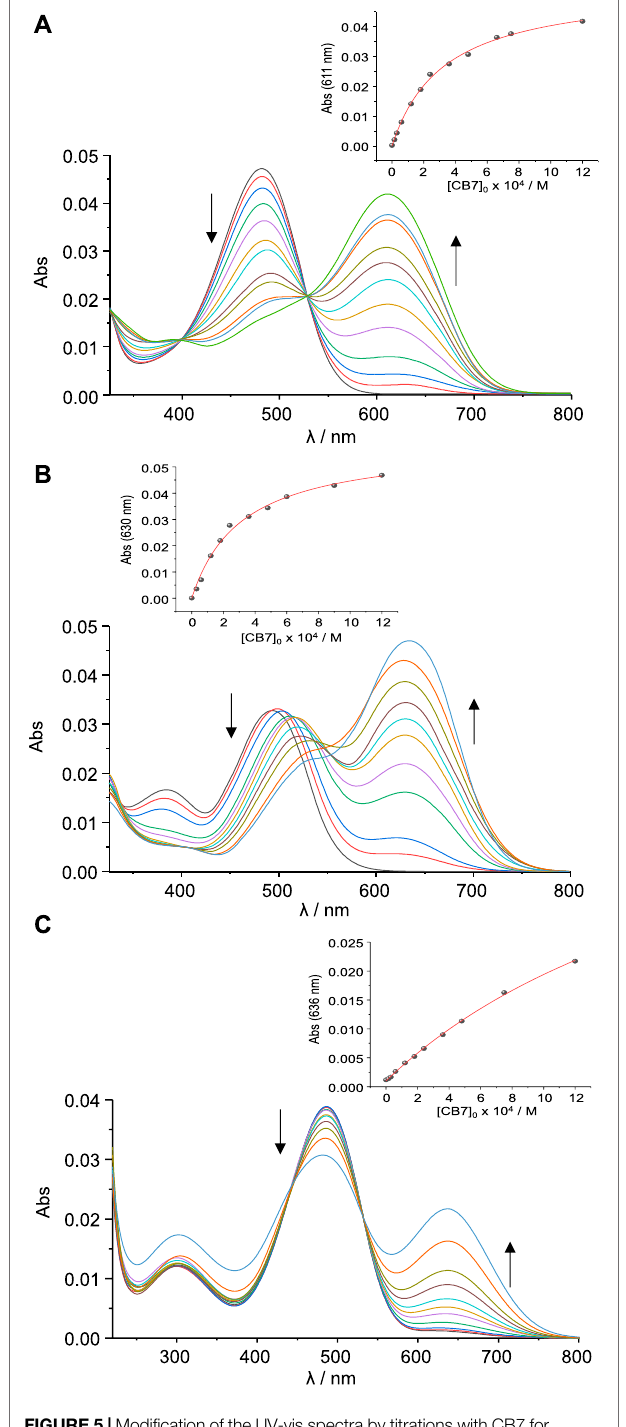
FIGURE 5 | Modi fi cation of the UV-vis spectra by titrations with CB7 for the SAC compounds (1.5 μ M at pH 2.5 in 30% methanol and T = 25.0 ° C): (A) SAC1 , (B) SAC2 and (C) SAC3